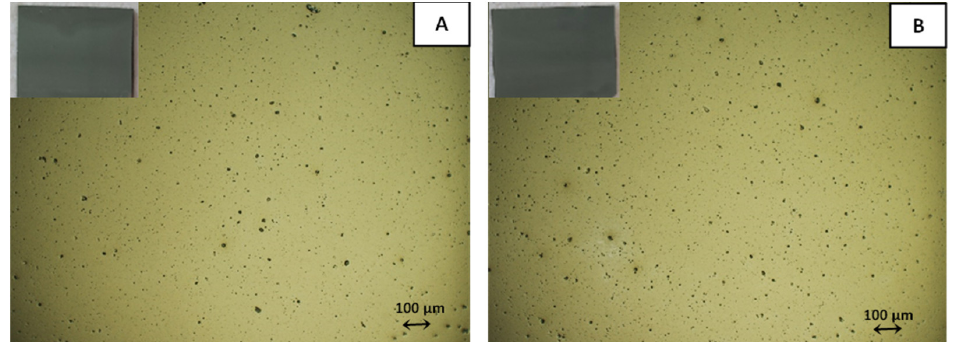
Figure 4. Examples of optical microscopy images of ink coatings after drying (15 min, 40 °C) before ( A ) and after ( B ) treatment with 1% OA.